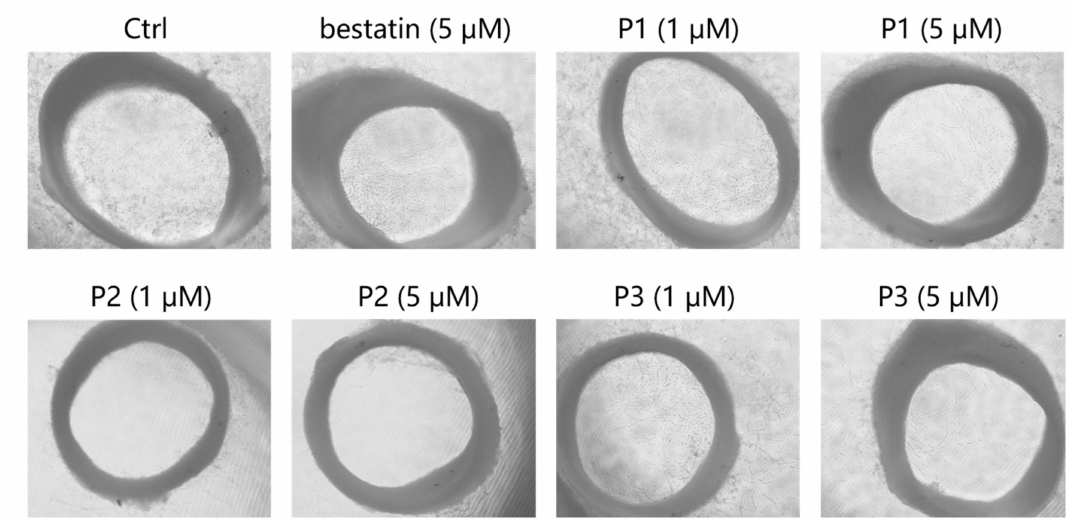
Figure 5. Representative images of the rat thoracic aorta rings treated with compounds at the indicated